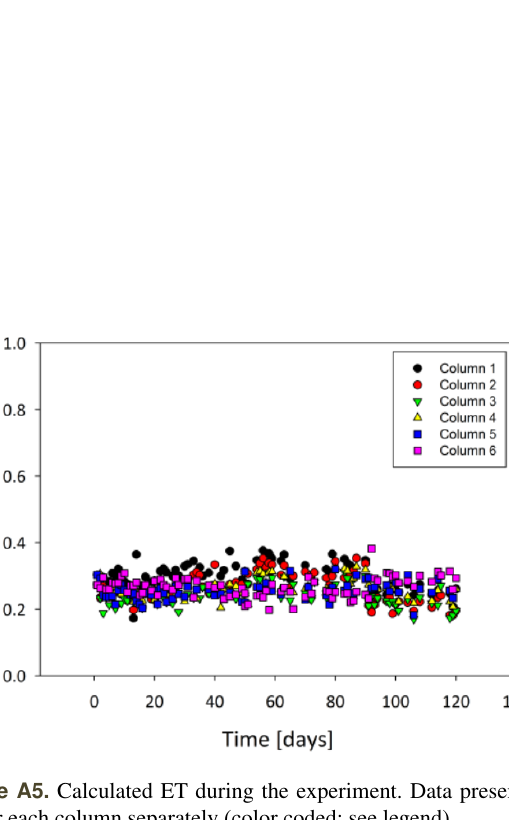
Figure A4. Soil water pressure measurements over time. The water table is marked at 0cm. Values around the − 10cm mark are from the low pressure meters of all six columns; values around − 20cm are from the high pressure meters.